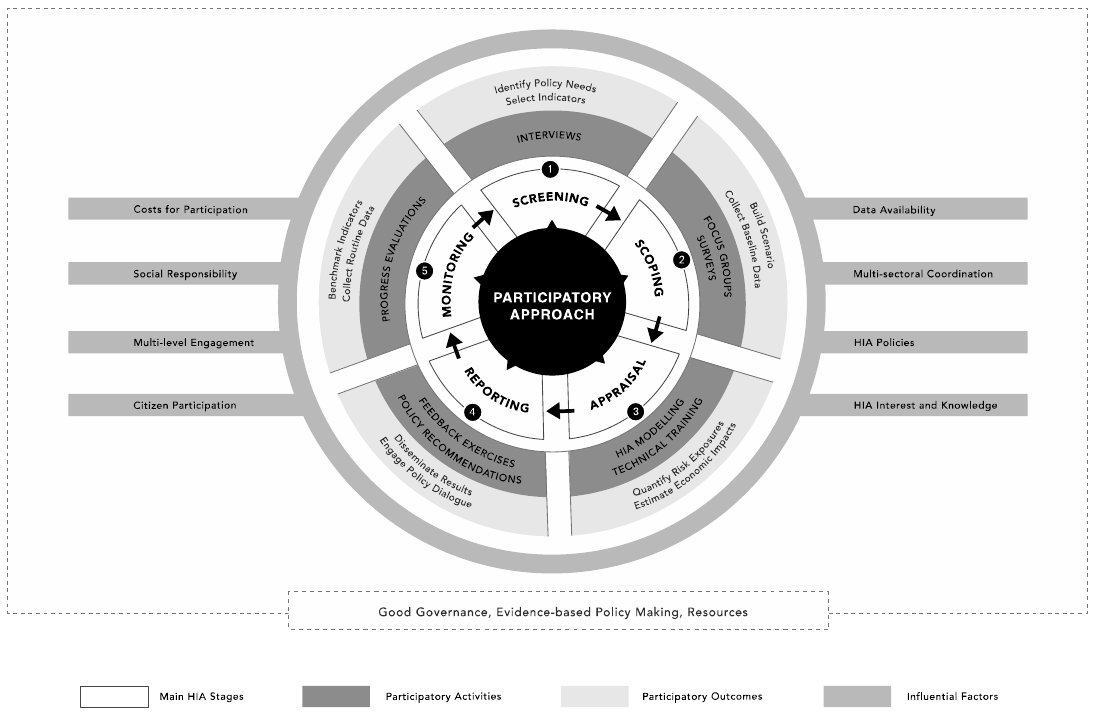
Figure 2. Participatory quantitative health impact assessment (PQHIA) framework. Note: for sake of visual clarity, the recommendation stage is presented as a sub-activity of the reporting stage, even if in practice this holds its importance as a stand-alone stage.